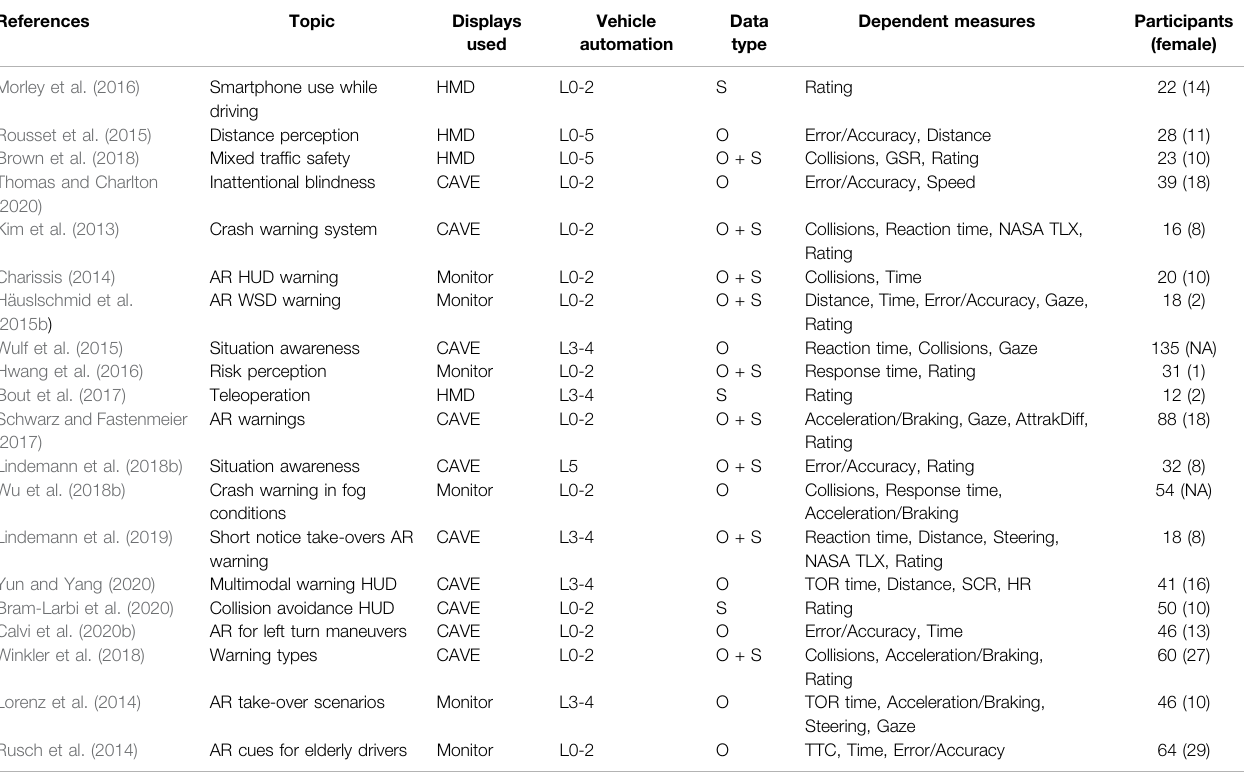
TABLE 5 | Summary of user studies in Safety application area.